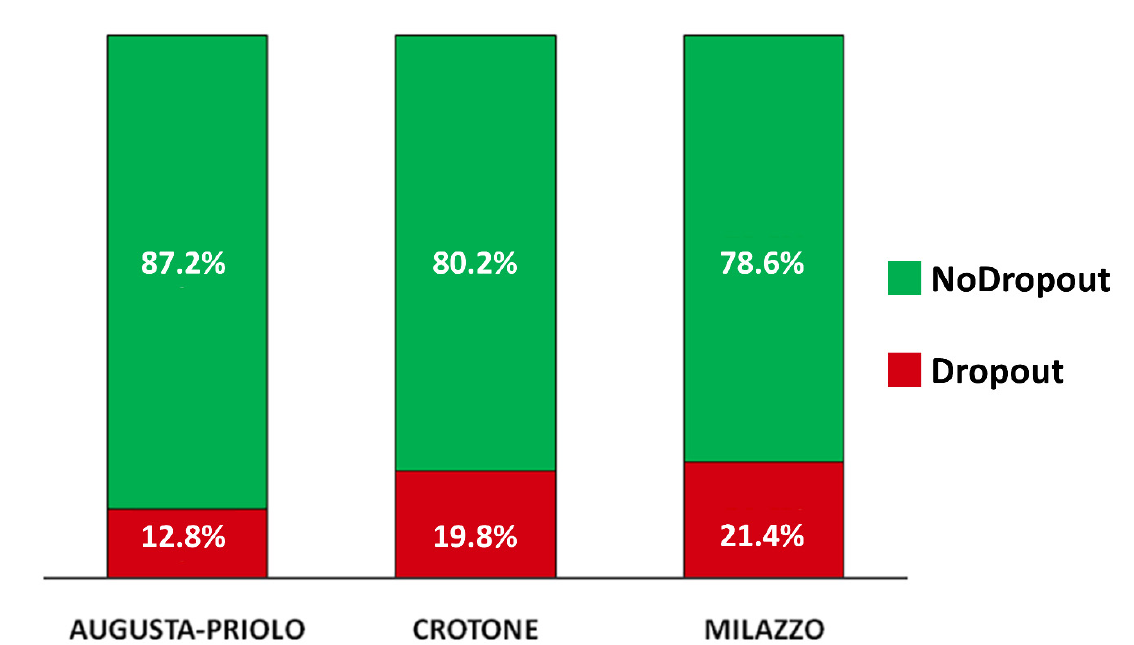
Figure 3. Distribution of dropouts within each national priority contaminated site.